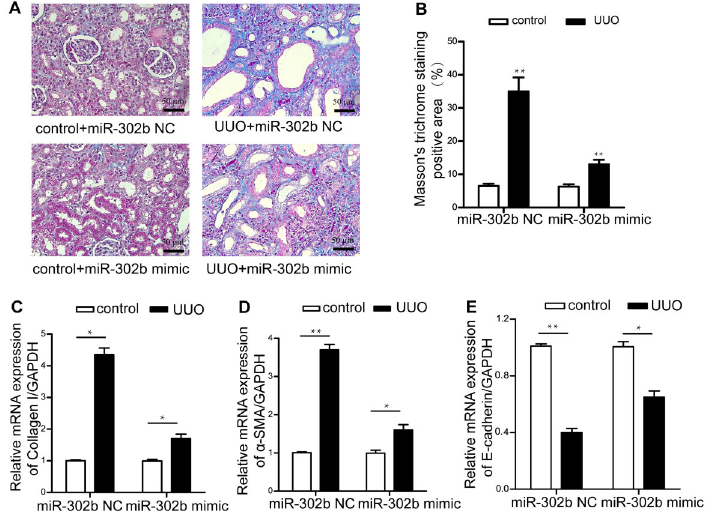
Figure 2. MiR-302b mimics reduced renal fi brosis and epithelial mesenchymal transition (EMT) progression. A , Representative Masson ’ s trichrome staining of control and unilateral ureteral obstruction (UUO) mice treated with miR-302b mimics or negative control (NC) sequences. Magni fi cation (cid:2) 200; bars 50 m m. B, Quantitative analysis of fi brotic area in the different groups mentioned above. The percentage of Masson ’ s trichrome staining positive area was calculated as follows: fi brotic area/total area of the fi eld. Relative mRNA